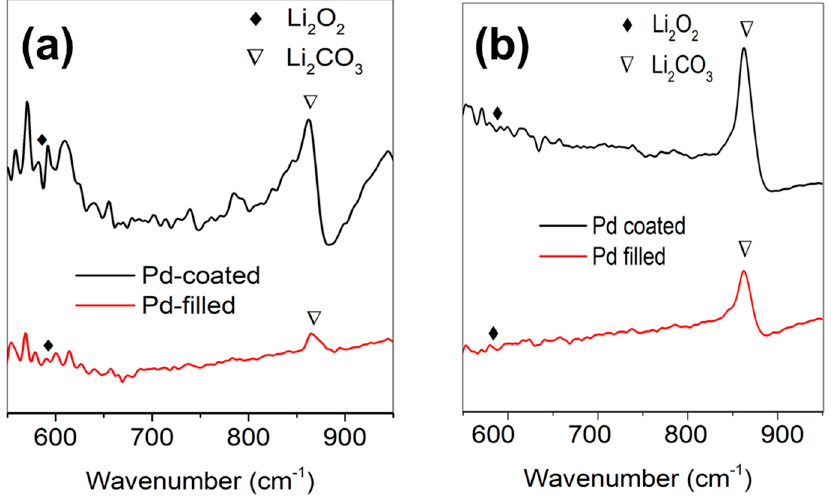
Figure 5. Fourier transform infrared (FTIR) spectra of PF- and PC-CNTs after cycling for ( a ) 45 cycles to 250 mAh.g − 1 and ( b ) 15 cycles to 1000 mAh.g − 1 .